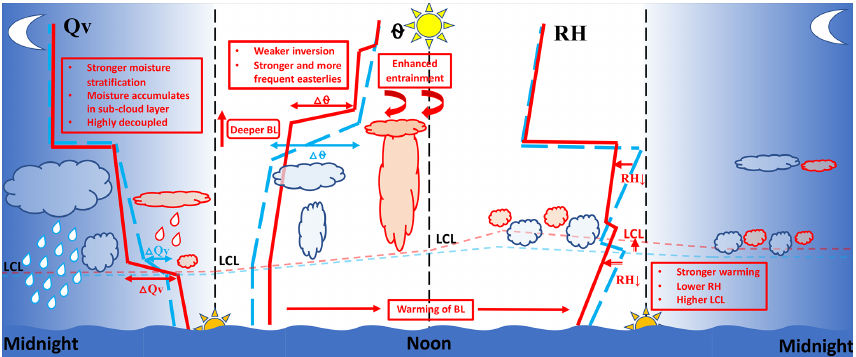
Figure 18. Schematic of the diurnal cycle for days with“less” (blue) and “more” (red) smoke, making use of the following abbreviations: Q v (water vapor mixing ratio), LCL (lifting condensation level), RH (relative humidity), (cid:49)(cid:50) (change in potential temperature), and BL (boundary